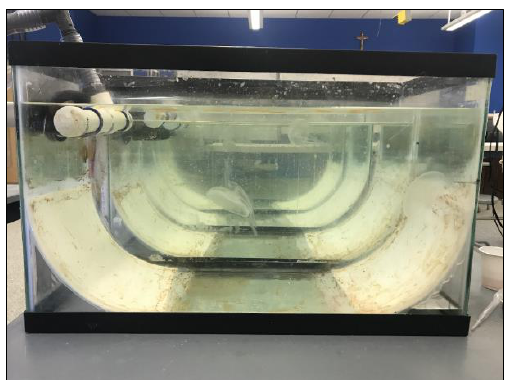
Figure 9. Depicts a side profile few of the